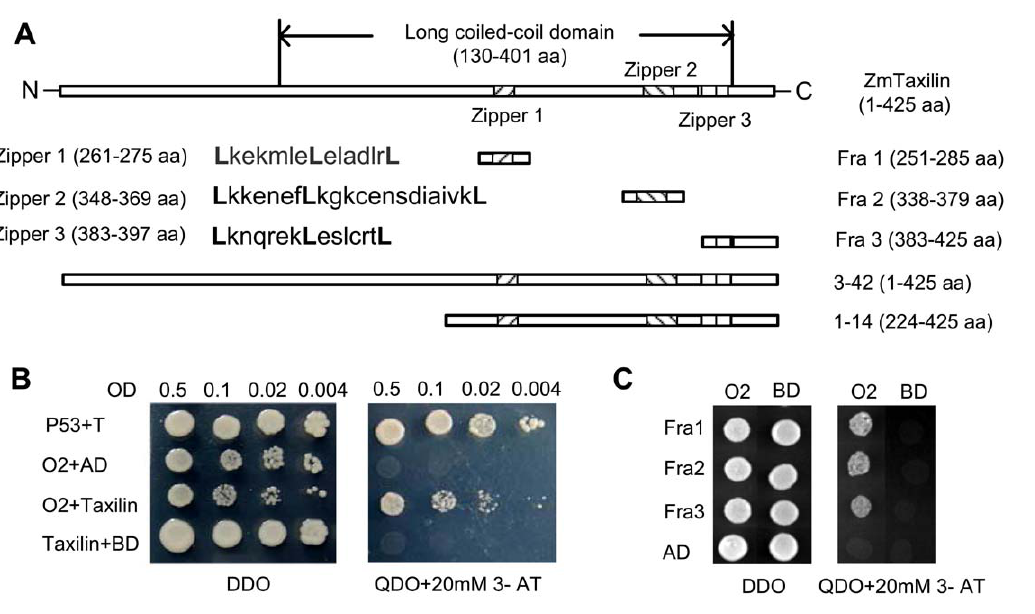
Figure 2. Yeast two-hybrid analysis of the interaction between ZmO2, full length ZmTaxilin and ZmTaxilin fragments. ( A ) Schematic representation of ZmTaxilin, Fra 1, Fra 2, Fra 3, 1–14 and 3–42. Fra 1, 2 and 3 are three fragments containing zippers 1, 2 and 3, respectively. 1–14 and 3–42 are two of the positive clones, and their corresponding proteins interact with O2-2 in yeast (Fig. 1B). ( B ) Full length ZmO2 interacts with full length ZmTaxilin in yeast cells. P53 + T is positive control in which P53 (murine P53) is fused to BD and SV40 (large T antigen) is fused to AD [43]. O2 + AD and Taxilin + BD are negative controls in which the BD-O2 fusion protein is co-expressed with AD or the AD-Taxilin fusion protein is co- expressed with BD. Yeast cells were cultured on selective media of DDO and QDO + 20 mM 3-AT in a dilution. ( C ) Full length ZmO2 interacts with Fra 1, 2 and 3 in yeast cells. Prey protein Fra 1, 2 and 3 were fused to AD and were co-transformed with O2 and the BD fusion protein. AD + ZmO2, AD + BD, Fra1 + BD, Fra2 + BD and Fra3 + BD are negative